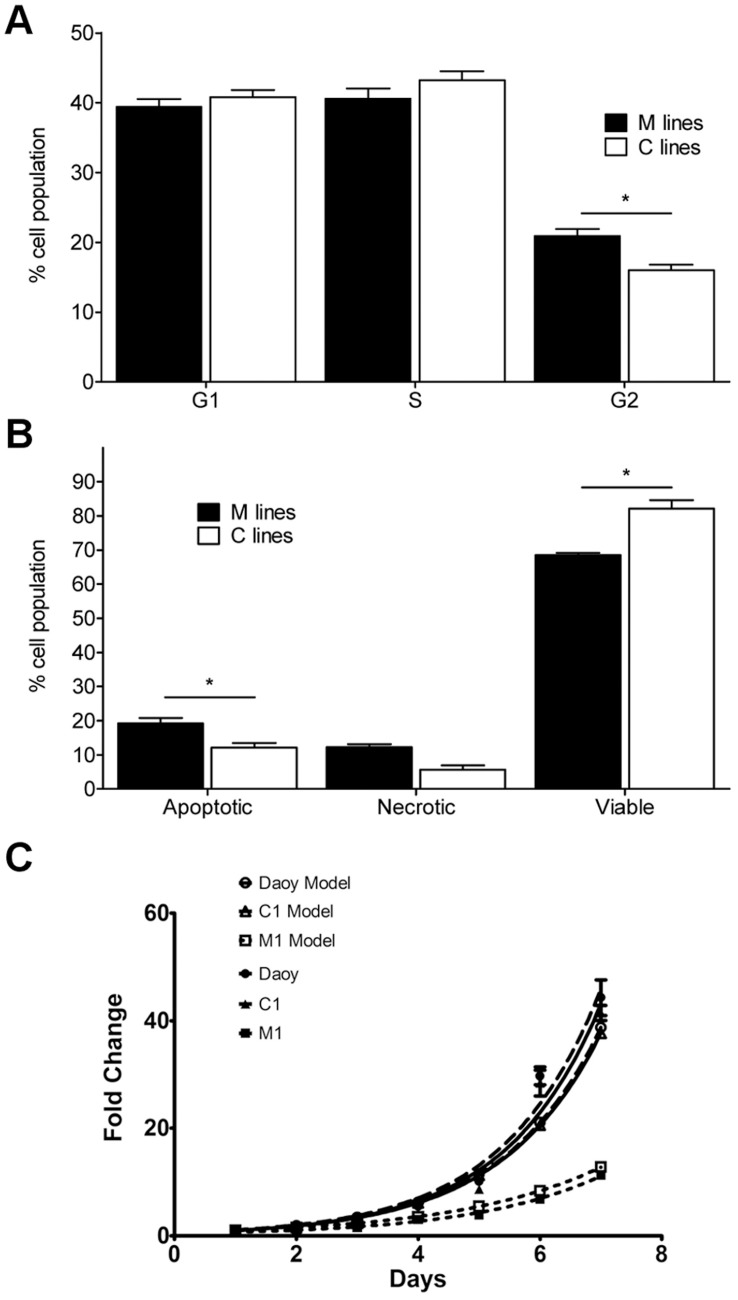
MXD3 influences cell cycle and apoptosis.(A−B) Cell cycle (A) and apoptosis (B) analysis by flow cytometry of MXD3 and control cell lines. Bars represent the average ± SD of two independent experiments, each performed on four MXD3 lines (“M”) and four control lines (“C”). MXD3 overexpression resulted in a significantly higher percentage of the population in the G2 phase and increased apoptosis (p<0.05, two-way ANOVA). (C) Theoretical proliferation curves (empty symbols) and experimental data (full symbols) for representative cell lines.